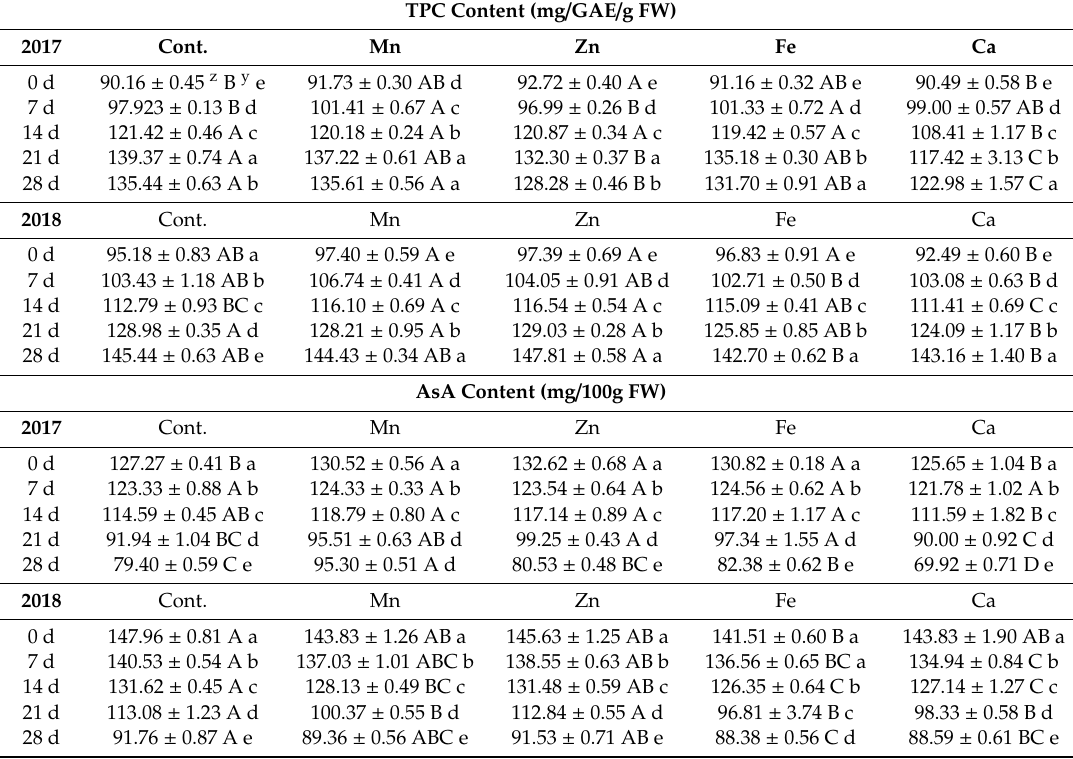
Table 2. E ff ect of foliar application of Ca, Mn, Zn, Fe elements plus water as the control on the total phenolic compound (TPC) and ascorbic acid (AsA) of broccoli stored for 28 days at 4 ◦ C. FW = fresh weight, GAE = gallic acid